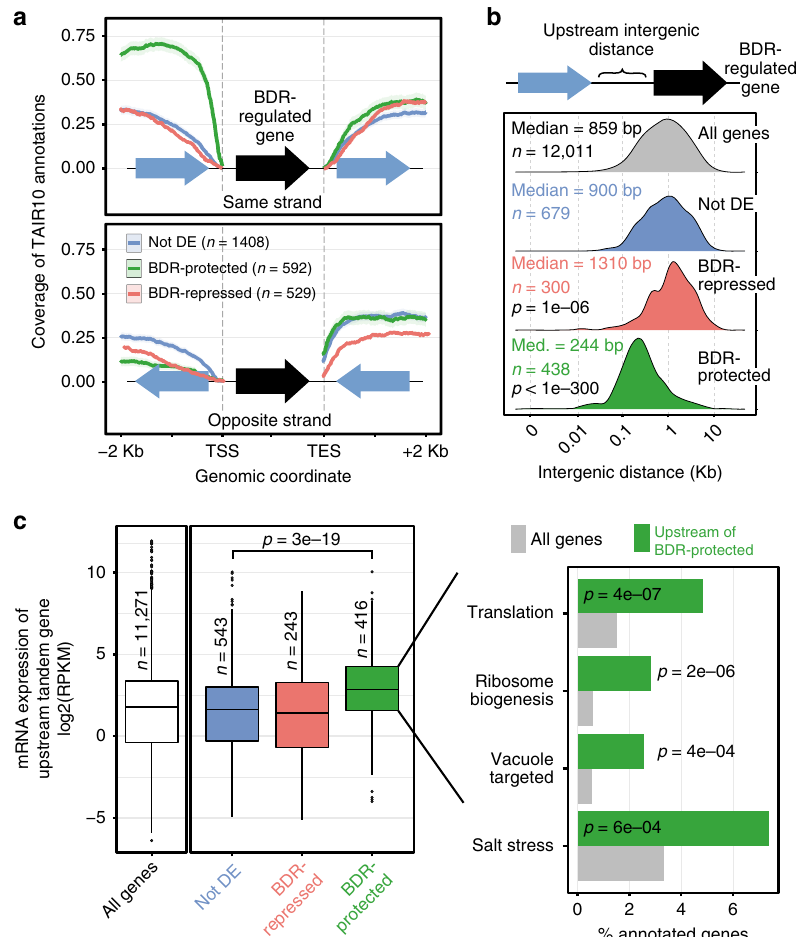
Fig. 5 Genes positively regulated by BDR proteins tend to have highly expressed upstream neighbors on the same strand. a Fraction of BDR-regulated genes that have upstream or downstream neighbors at various orientations, within the indicated distances. b BDR-protected genes and their upstream tandem neighbors have short intergenic distances. Distribution of intergenic distances between tandem genes. Distribution differences relative to all genes were evaluated by Kolmogorov – Smirnov test with BH correction. c The upstream tandem neighbors of BDR-protected genes have relatively high expression levels. Wild-type gene expression levels for upstream tandem neighbors from the indicated groups of genes (left panel). Differences are evaluated by Mann – Whitney U test. Right panel, gene ontology analysis (goseq R package) of the upstream tandem neighbors of BDR-protected genes. Categories with p < 0.001 are shown. The centerline of the boxplot is the median. The bounds of the box are the fi rst and third quartiles (Q1 and Q3). Whiskers represent data range but are bounded to 1.5-fold the interquartile range (Q3 – Q1); points outside this range are represented